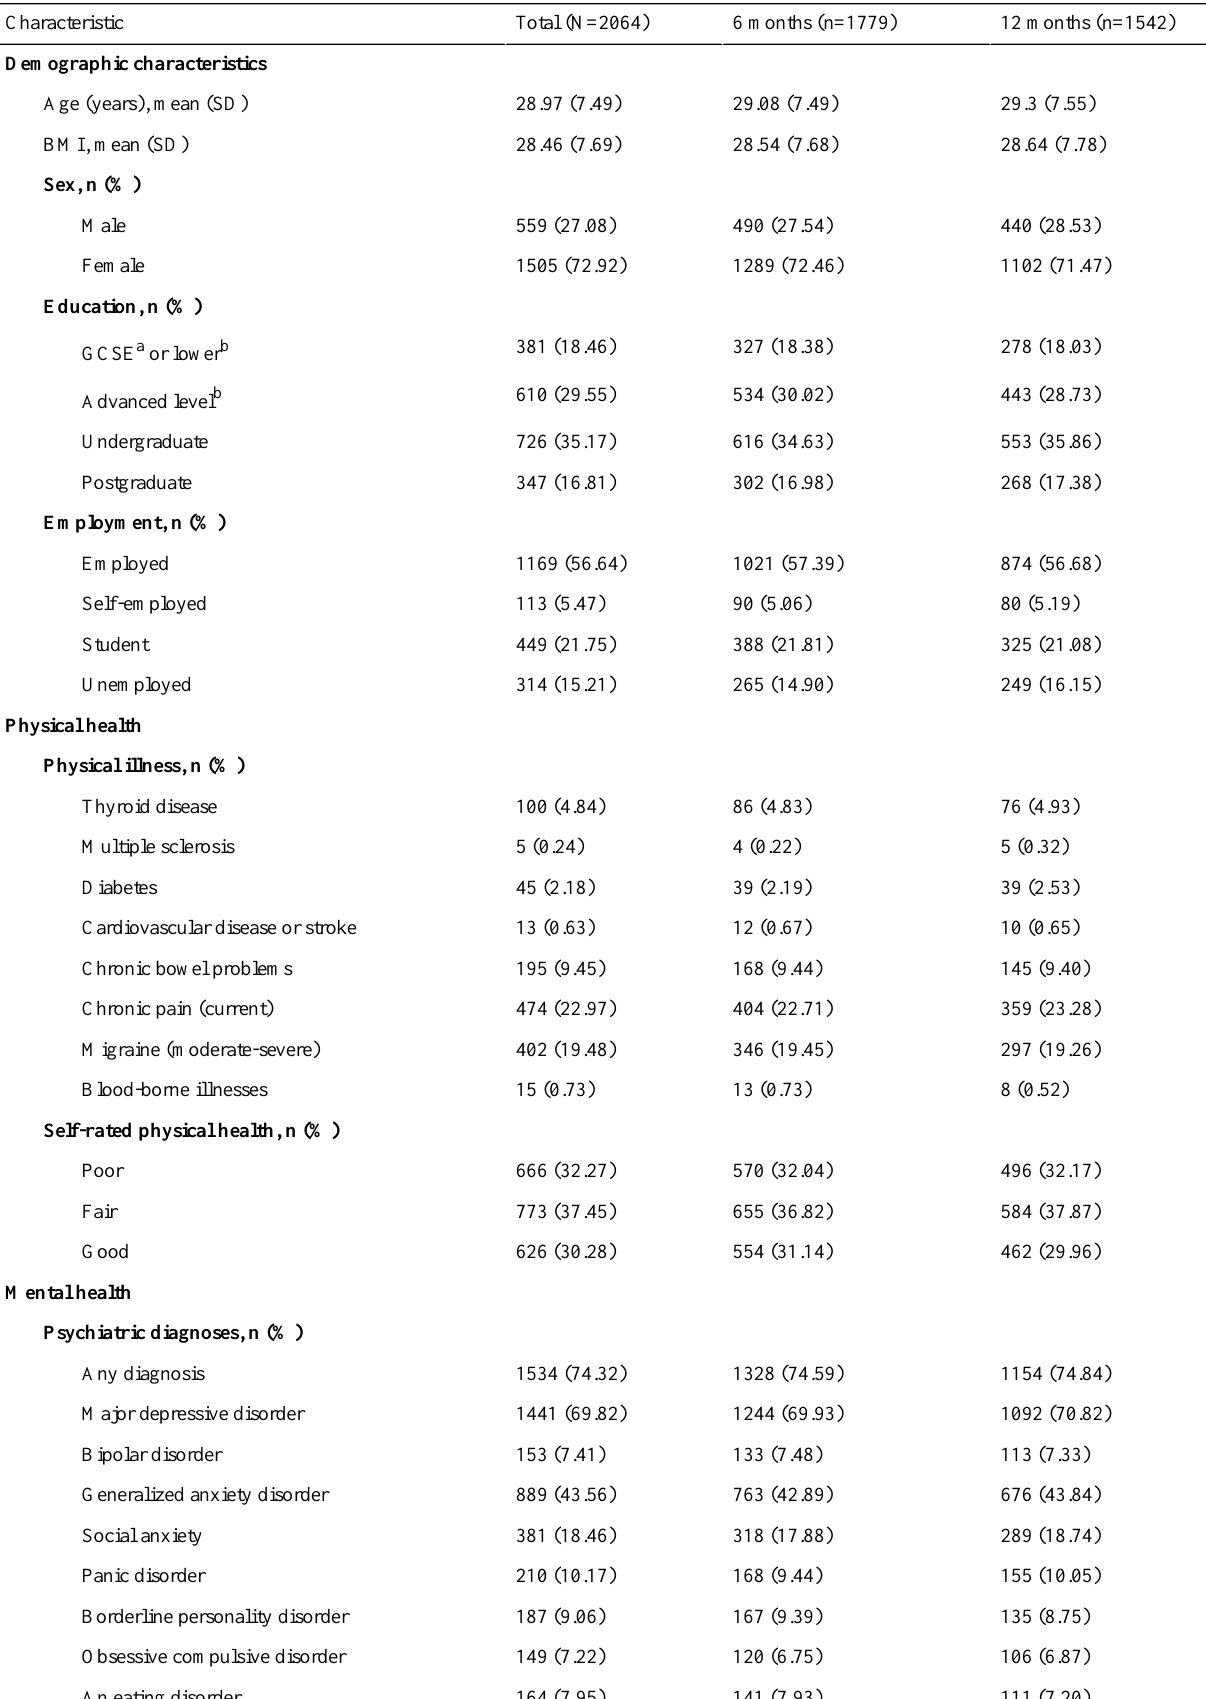
Table 1. Demographic, physical, and mental health characteristics of Delta Study participants at follow-ups